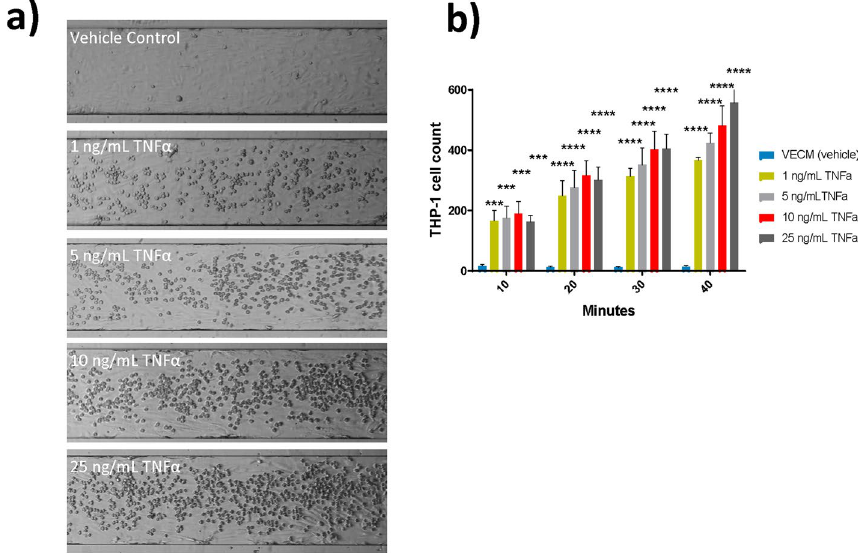
Figure 1. Monocyte adhesion to HAECs following 24 h TNFα exposure in the BioFlux microfluidic system. ( a ) Representative bright field images of BioFlux microfluidic channels captured after the 40 min adhesion period using a Zeiss Axio Observer.Z1 microscope (×10 magnification). ( b ) Quantification of monocyte adhesion to HAECs over a course of adhesion periods (10, 20, 30 and 40 min) following 24 h HAEC exposure to a TNFα dose range (1–25 ng/mL). Two-way ANOVA with Dunnett’s multiple comparisons between vehicle control and each TNFα concentration. Error bars denote ± SD (n = 3); ***p < 0.001 ****p <